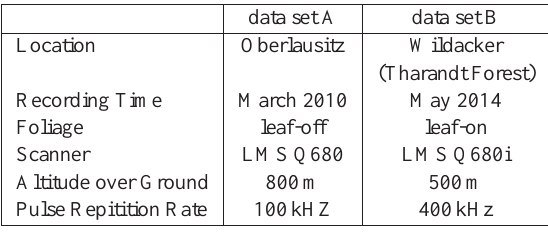
Table 1: Description of data sets